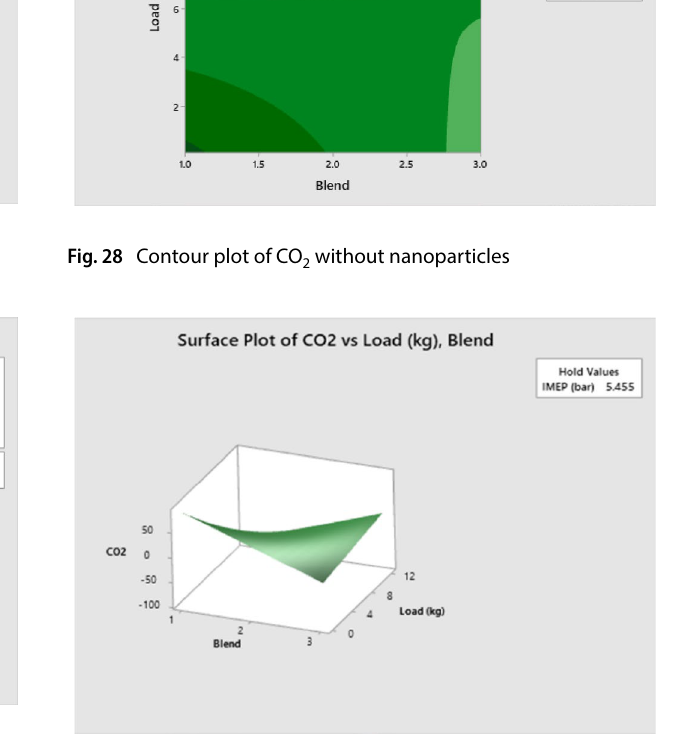
Fig. 29 Surface plot of CO